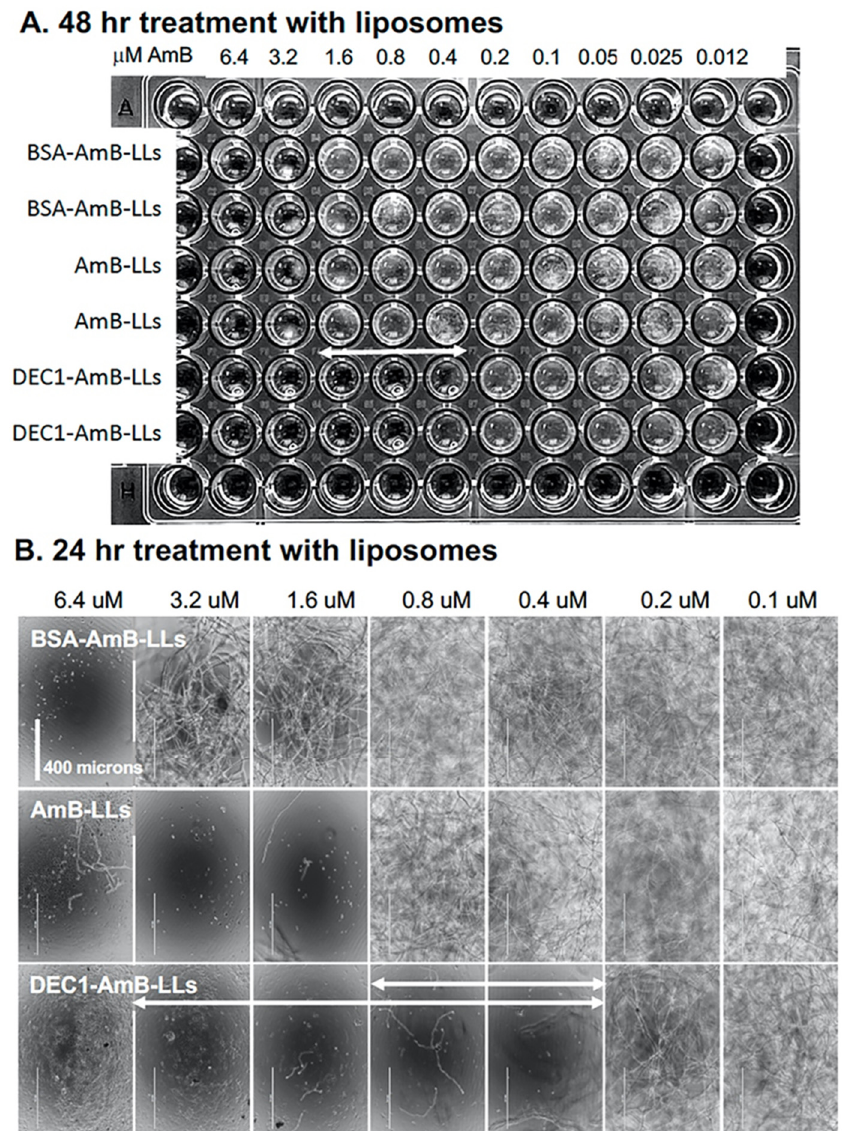
Figure 4. Qualitative DEC1-AmB-LL inhibition and killing assays based on cell growth and density. ( A ) R. delemar sporangiospores diluted into liquid RPMI + MOPS media were immediately treated with either BSA-AmB-LLs, AmB-LLs, or DEC1-AmB-LLs delivering the indicated AmB concentrations and incubated at 37 °C. An overview image showing hyphal density was taken 48 h after treatment. The two-headed arrow indicates the range at which DEC1-AmB-LLs significantly inhibited R. delemar growth as compared to the control liposome treatments. ( B ) Images of the center of each well from the same plate had been taken 24 h after treatment at 10× magnification. The two two-headed arrows indicate the ranges at which DEC1-AmB-LLs significantly inhibited R. delemar growth compared to the controls at this earlier time point. The size bar indicates 400 microns.